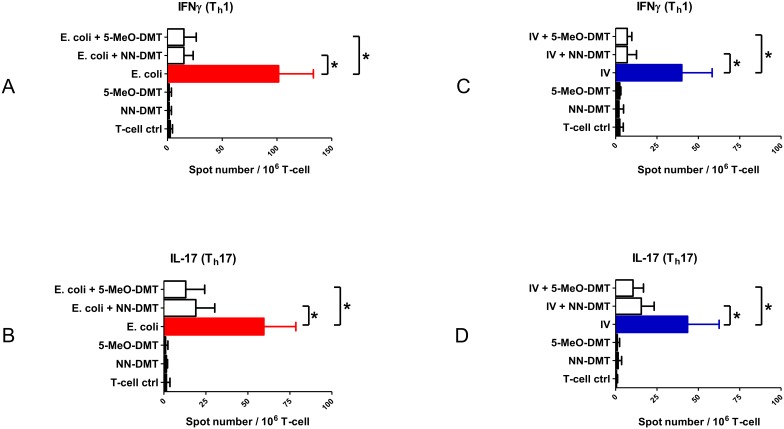
NN-DMT and 5-MeO-DMT pre-treatment of pathogen-activated human dendritic cells effectively inhibit their capacity to prime autologous naive T helper 1 and T helper 17 cells.Dendritic cells were activated either by heat-killed E. coli (E. coli) or inactivated influenza virus (IV) for 24 h, washed, and then co-cultured with naive autologous CD4+ T lymphocytes for 4 days. The number of primed, IFNγ or IL-17 secreting T cells was assessed by ELISPOT assay. T cells alone (T-cell ctrl), and non-activated DCs treated with DMT and co-cultured with autologous naive CD4+ T lymphocytes (NN-DMT, 5-MeO-DMT) were used as controls. A–B: Induction of IFNγ (A) or IL-17 (B) production of autologous naive CD4+ T cells induced by moDC loaded by E. coli. Bacteria alone (E. coli; red bars) or bacteria in combination with 1 h DMT pre-treatment (E. coli + NN-DMT, E. coli+5-MeO-DMT; empty bars) were used to activate moDCs as written above. C–D: Cells were activated as in Fig4A–B; in this case inactivated influenza virus (IV) was added to the moDCs alone for 24 h (blue bars), or in combination with an 1 h NN-DMT or 5-MeO-DMT pre-treatment (IV + NN-DMT, IV + 5-MeO-DMT; empty bars). Data represent Mean + SEM values of triplicate measurements of three independent donors. Asterisk indicates statistical significance (p<0.05).